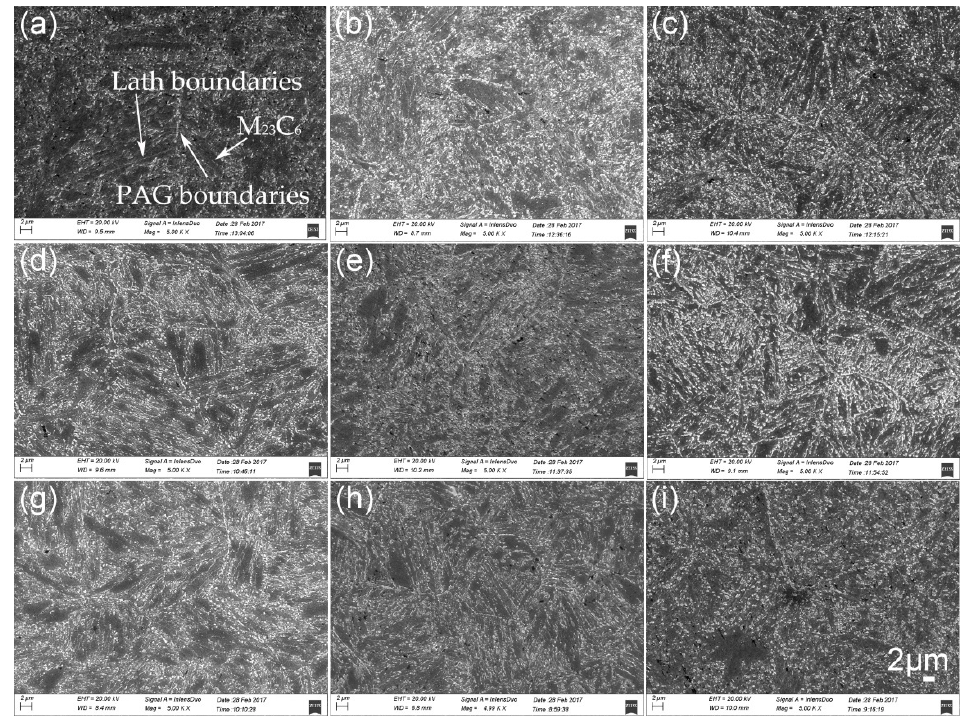
Figure 8. SEM micrographs of M 23 C 6 in 15Cr12MoVWN steel specimens under conditions of ( a ) 0W,